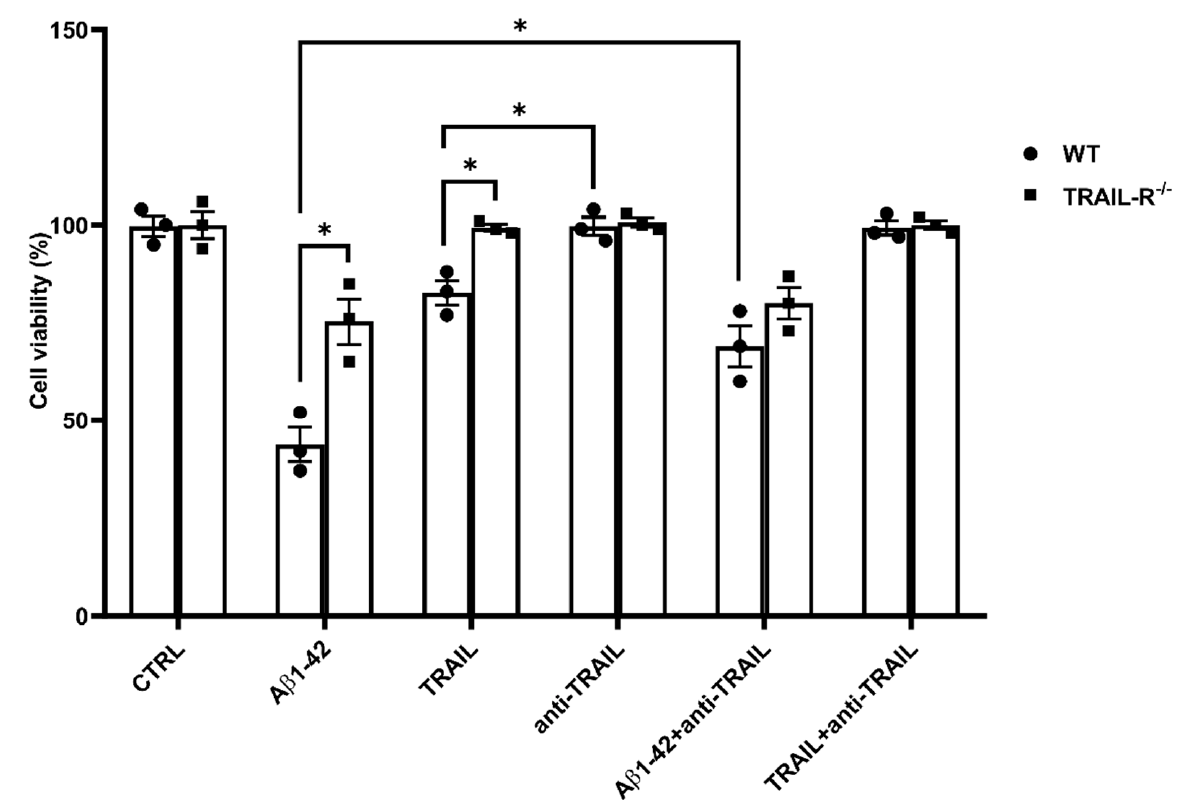
Figure 2. Amyloid beta neurotoxicity is attenuated in TRAIL-R − / − mouse primary hippocampal cells. Cell viability of primary embryonic hippocampal neurons from WT and TRAIL-R − / − mice, following 48h treatment with A β 1-42 (1 µM), TRAIL (100 ng/mL), anti-TRAIL antibody (1 µg/mL), or various combinations of the compounds. Vertical bars are means ± standard error mean (SEM). One-way ANOVA and the Bonferroni post-hoc test were used for statistical analysis. * p < 0.05.